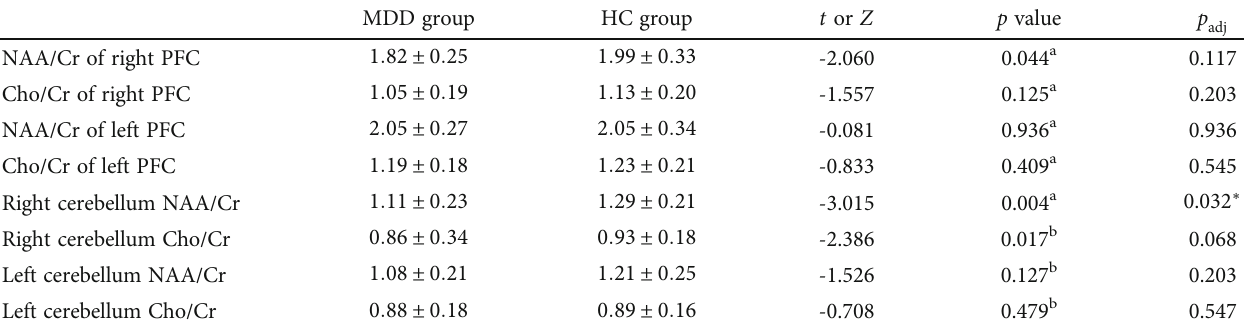
Table 3: Comparison of PFC and cerebellum biochemical metabolite